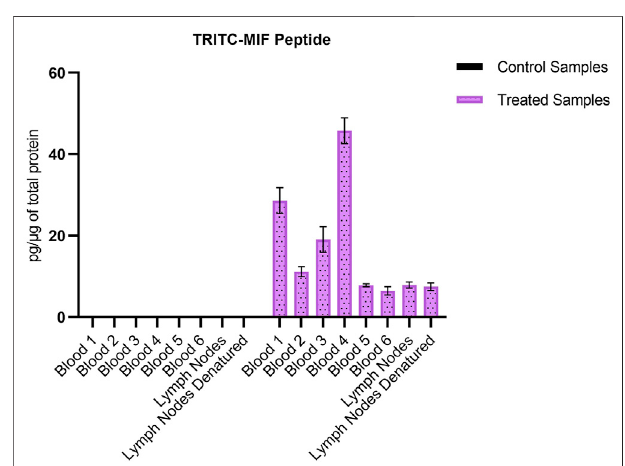
FIGURE 3 | Amount of TRITC-modi fi ed MIF peptide per µg of total protein in the different whole blood and lymph node samples. Values are the mean of three replicate analysis ±